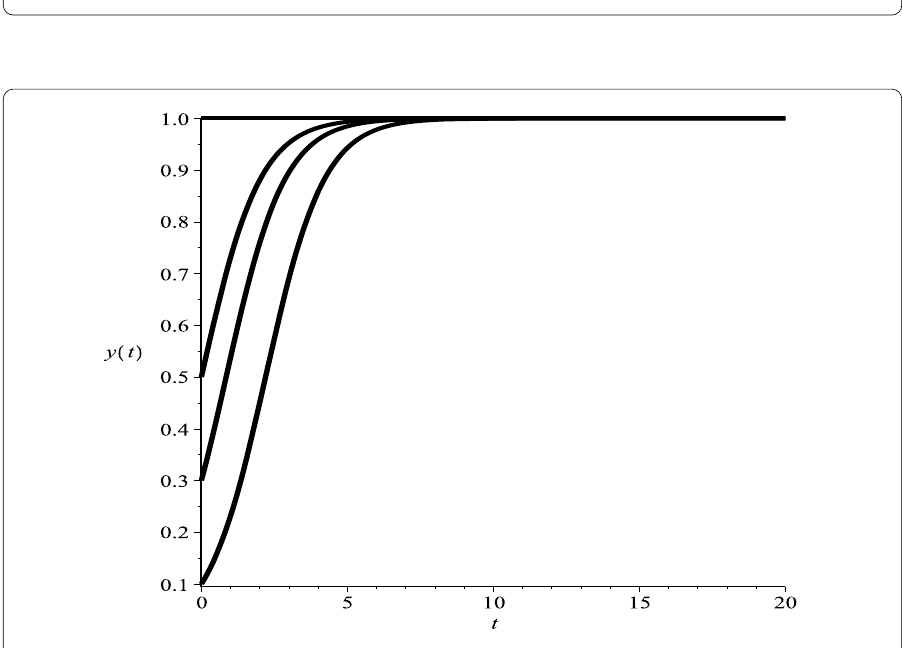
Figure 4 Dynamic behaviors of the third component y ( t ) of system (4.1), here we take d = 1/4 and the initial conditions ( x 1 (0), x 2 (0), y (0)) = (0.5,0.5,0.5), (0.1,0.1,0.1), (1,1,1), and (0.3,0.3,0.3), respectively